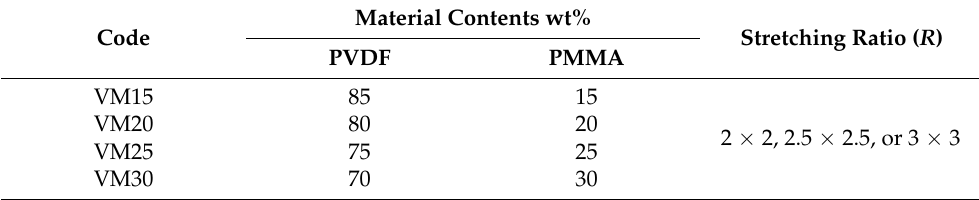
Table 1. List of PVDF/PMMA blend (VM)